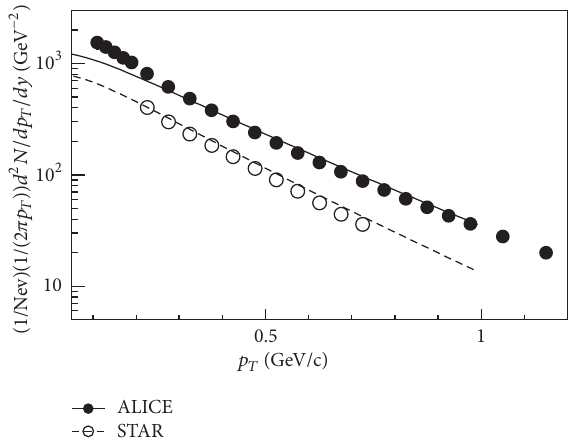
Figure 3: Comparison of pion’s spectra from blast-wave model (lines) and the data in central Au+Au collisions at √𝑠 [43] and the data in central Pb+Pb collisions at √𝑠